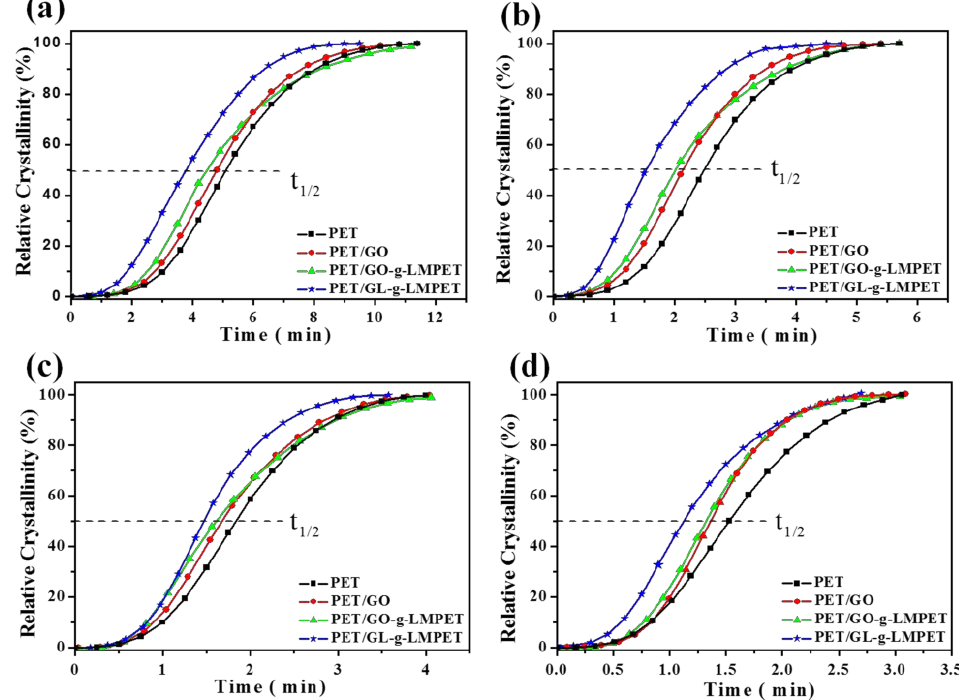
Figure 10. Plots of relative degree of crystallinity ( X t ) versus crystallization time ( t ) for pure PET, PET/GO, PET/GO- g -LMPET, and PET/GL- g -LMPET at different cooling rates. ( a ) 5 ◦ C · min − 1 ; ( b ) 10 ◦ C · min − 1 ; ( c ) 15 ◦ C · min − 1 and ( d ) 20 ◦ C · min − 1 .